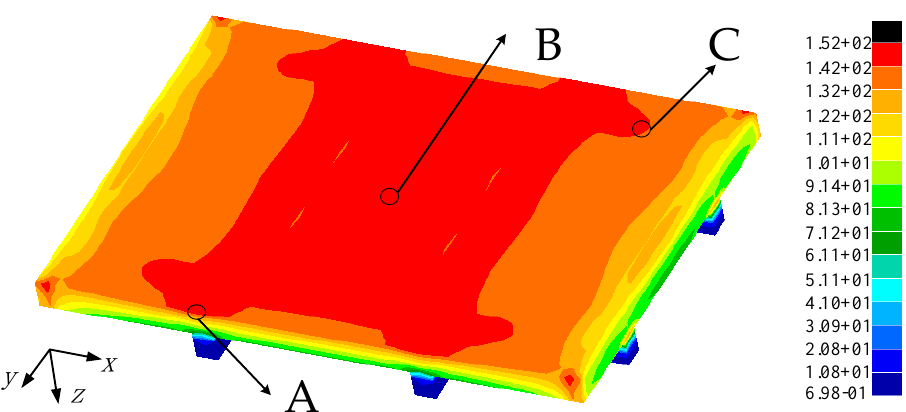
Figure 8. Forms of applied load.